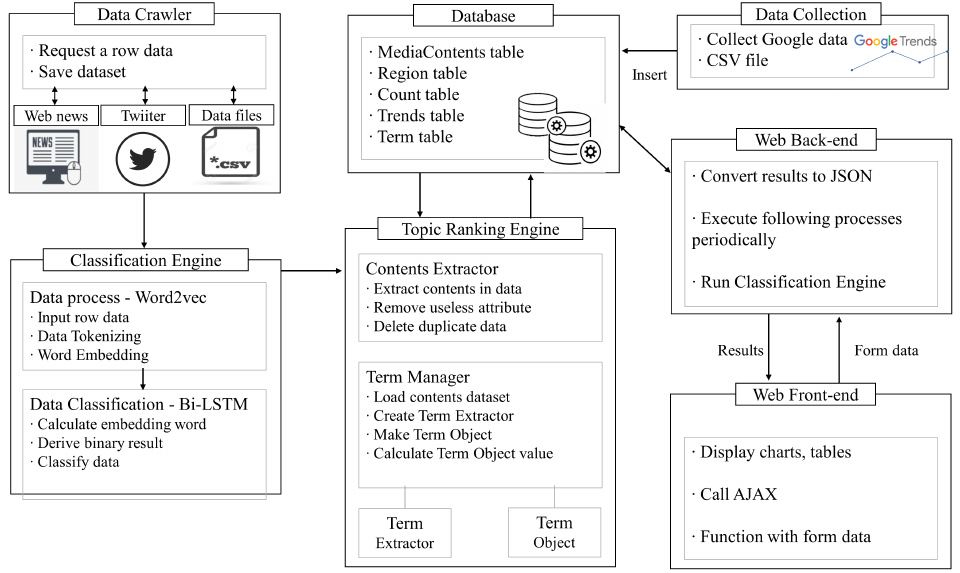
Figure 2. System architecture of our proposed